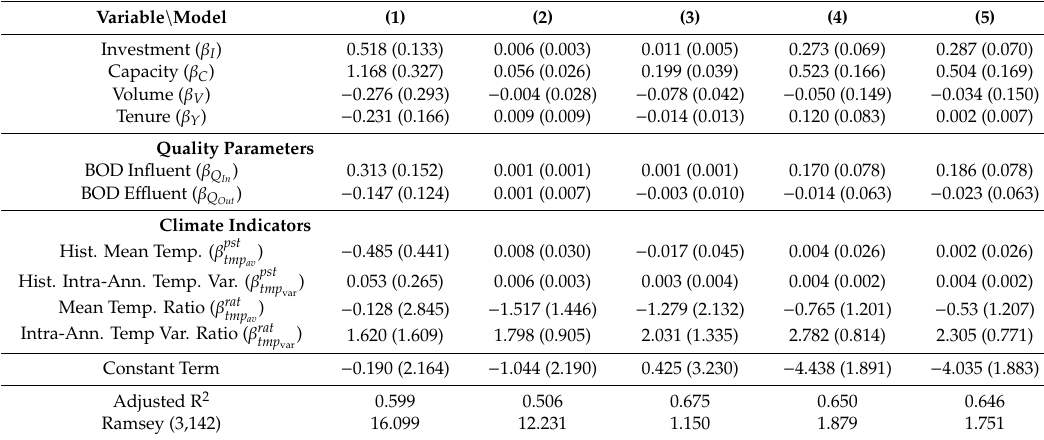
Table A1. Di ff erent functional form specifications.